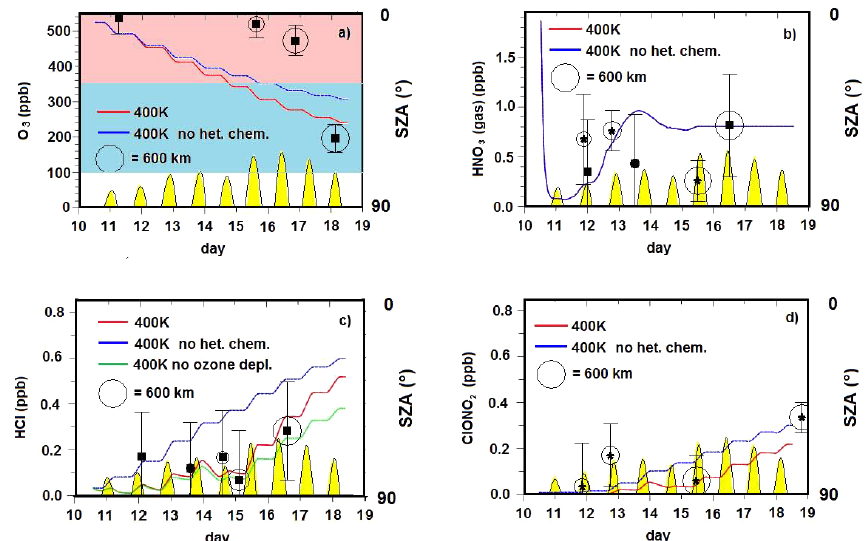
Figure 6. MLS (squares) and MIPAS (stars) observations and model results with (red line) and without (blue line) heterogeneous chemistry. (a) (Upper left panel) O 3 : the colored areas highlight the range of variability of O 3 values observed by the balloon-borne ozonesonde in the 400 ± 10K air layer that returned over the Ross Sea less than 300km from McMurdo: red for the first flight, blue for the second flight; (b) (upper right) HNO 3 ; (c) (lower left) HCl; (d) (lower right) ClONO 2 . The radius of the circles surrounding the data points represents the match radius. Yellow areas indicate sunlit parts of the trajectory; the corresponding solar zenith angle (SZA) is reported on the right vertical